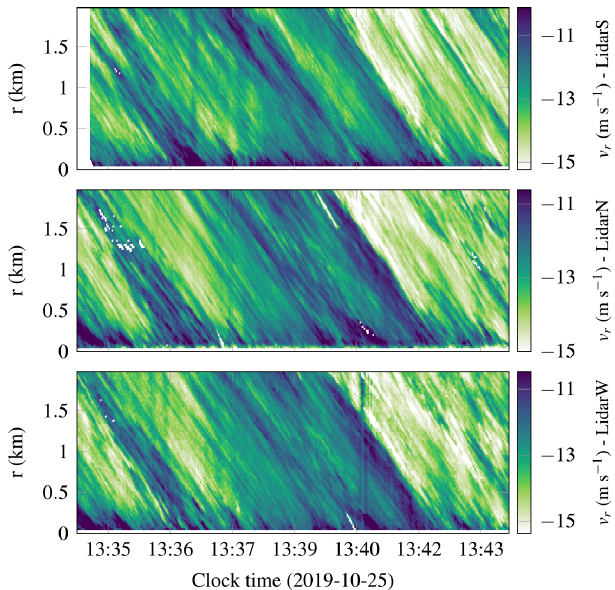
Figure 14. Along-beam velocity component simultaneously recorded on 25 October 2019 by the three scanning lidar instru- ments at every range gate.